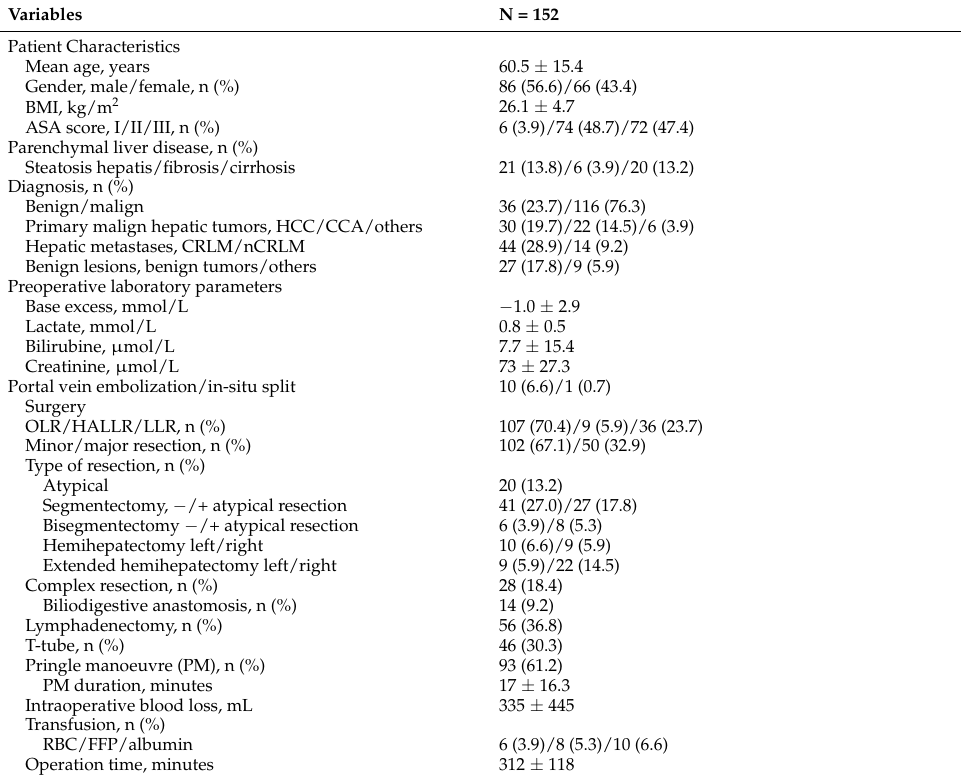
Table 1. Baseline characteristics of the overall study population. Variables N =